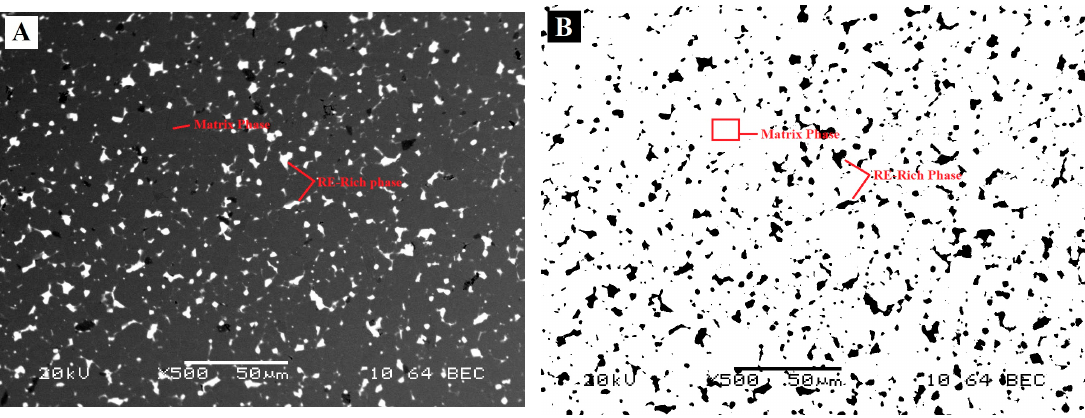
Figure 3. ( A ) Backscattered SEM image; ( B ) Binary image of SEM produced by Image J.